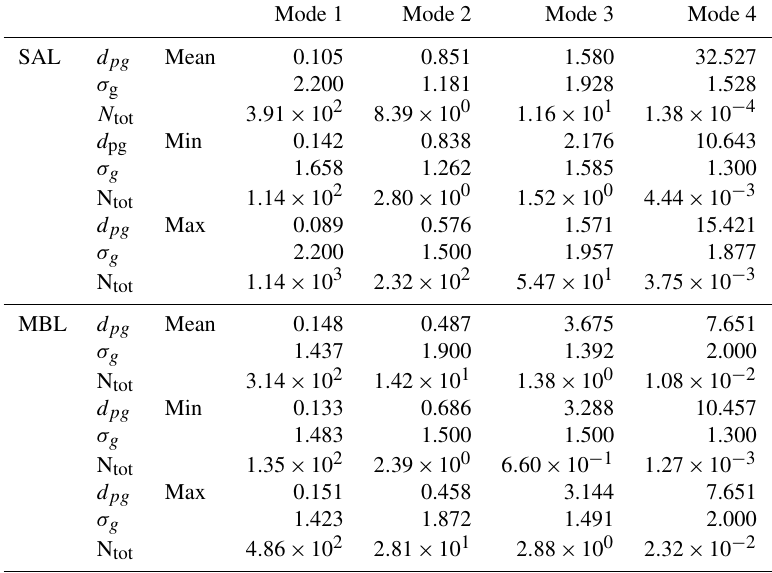
Figure 5. Size distributions for SLRs (a) in the SAL and (b) in the MBL, for the PCASP, CDP and 2-DS XY. Errors combine systematic and random errors. For clarity only upper error bounds are shown. The following numbers of SLRs were performed per flight in the SAL and are shown in panel (a) : b920 (2), b924 (1), b928 (6), b932 (2), b934 (3). One SLR per flight was performed in the MBL as shown in panel (b) . Table 5. Lognormal mode properties for the number size distribution. Diameters are given in microns, number concentrations in ambient cm − 3 . d pg represents the median diameter, σ g represents the geometric standard deviation and N tot represents the total aerosol number concentration. Mode 1 Mode 2 Mode